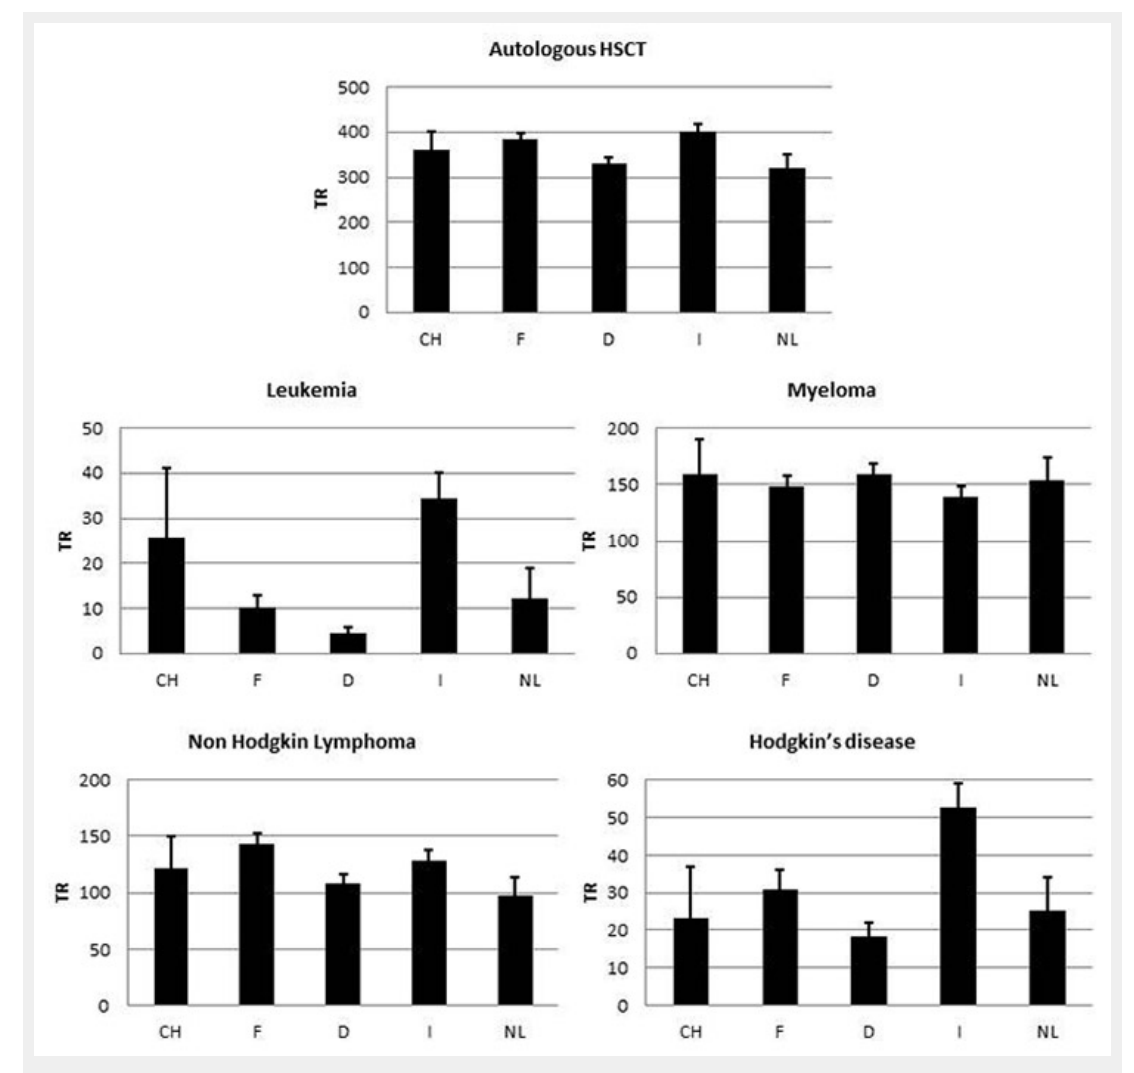
Figure 5 Autologous HSCT rates per 10 million inhabitants per year. 5a: autologous HSCT. 5b: leukaemia. 5c: myeloma. 5d: non-Hodgkin’s lymphoma. 5e: Hodgkin‘s disease (CH: Switzerland, F: France, D: Germany, I: Italy, NL: the